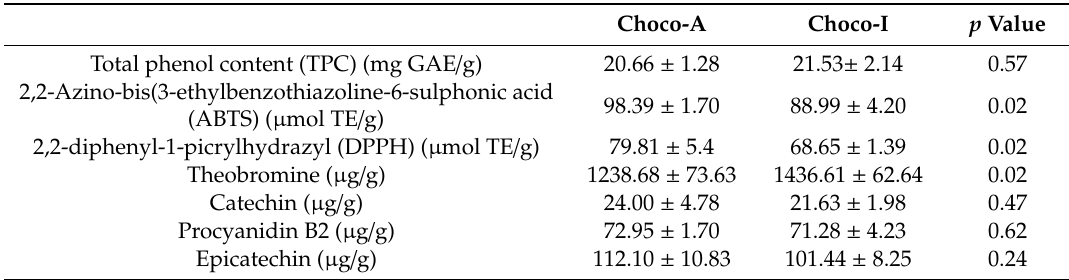
Table 4. Chemical analyses of